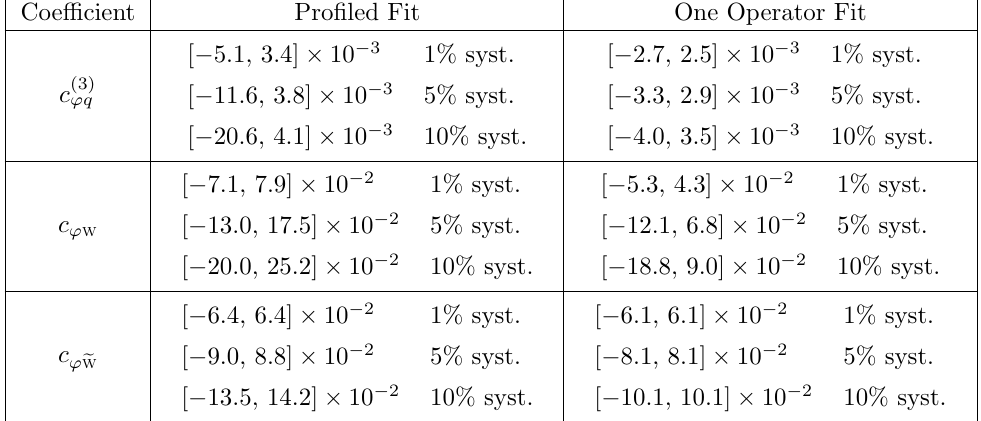
Table 6 . Bounds at 95% C.L. on the coe(cid:14)cients of the O (3) ’q , O ’ w and O (cid:3) = 1 TeV. Left column: bounds pro(cid:12)ling over the other two coe(cid:14)cients. Right column: bounds with a one operator (cid:12)t, i.e. setting the other two coe(cid:14)cients to